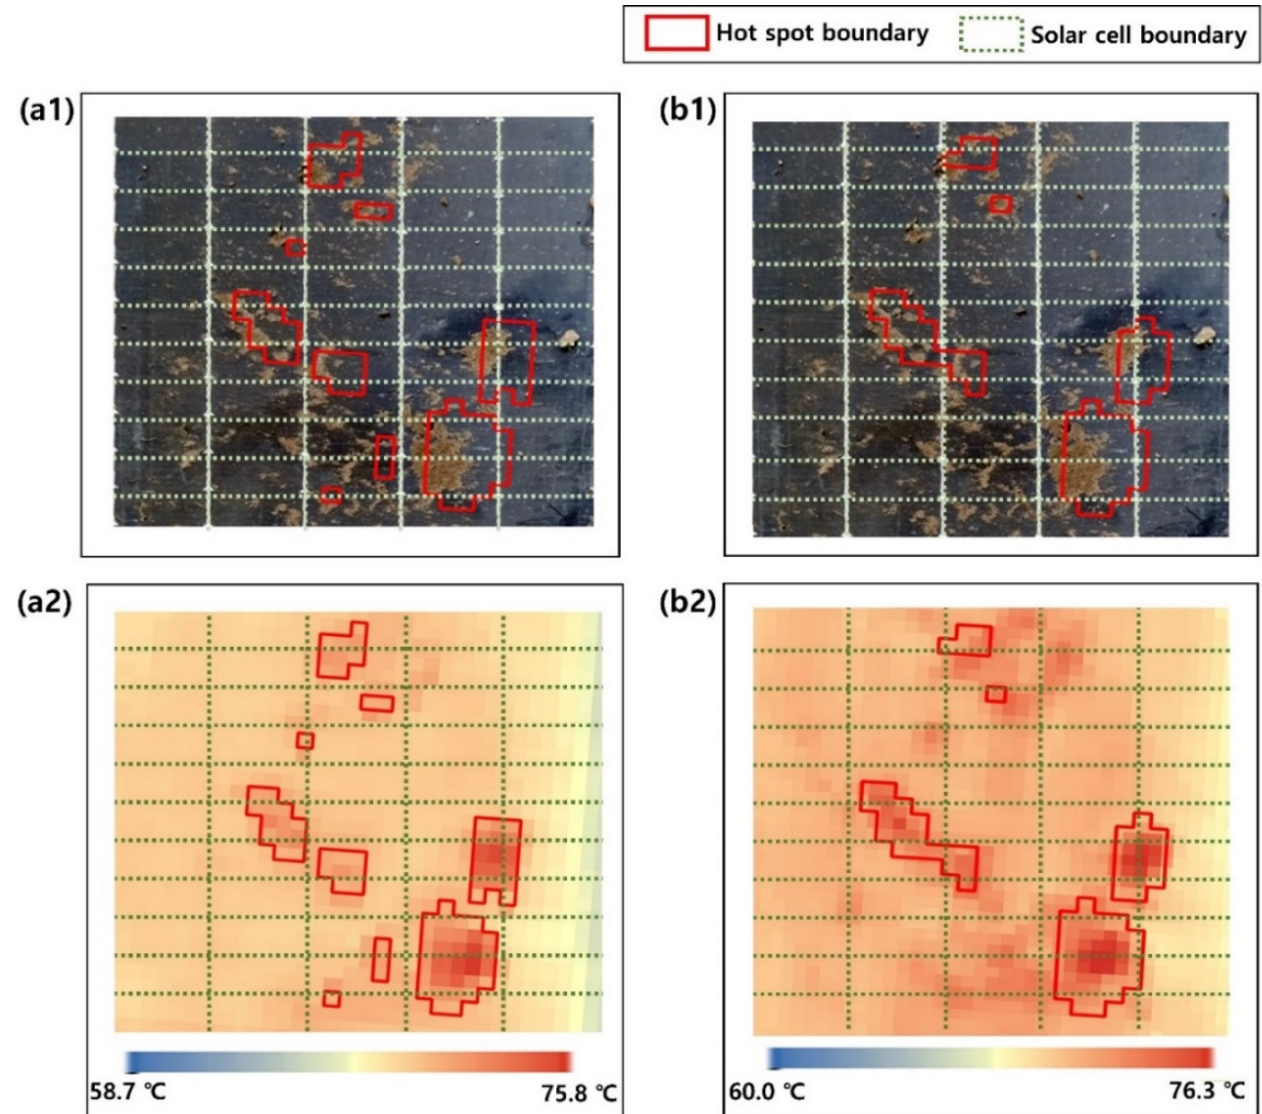
Figure 5. Comparison of magnified image and hot spots between the photo-mosaic and video-mosaic. ( a1 ): in situ photo and hot spot boundary detected from photo-mosaic; ( a2 ): photo-mosaic and hot spot boundary detected from photo-mosaic; ( b1 ): in situ photo and hot spots detected from video-mosaic; ( b2 ): video-mosaic and hot spot boundary detected from video-mosaic. See the location of the image in Figure 4.